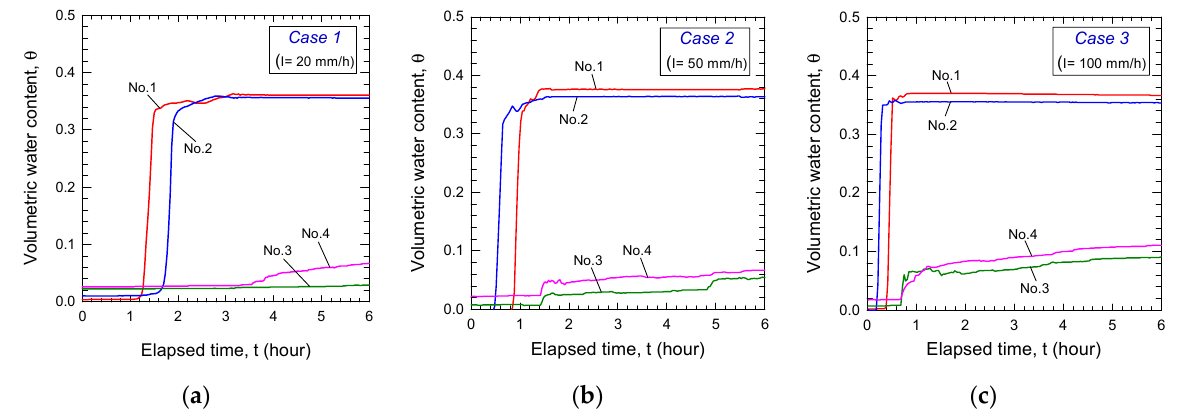
Figure 6. Measured volumetric water contents ( θ ) for each case: ( a ) Case 1 (I = 20 mm/h); ( b ) Case 2 (I = 50 mm/h); ( c ) Case 3 (I = 100 mm/h).